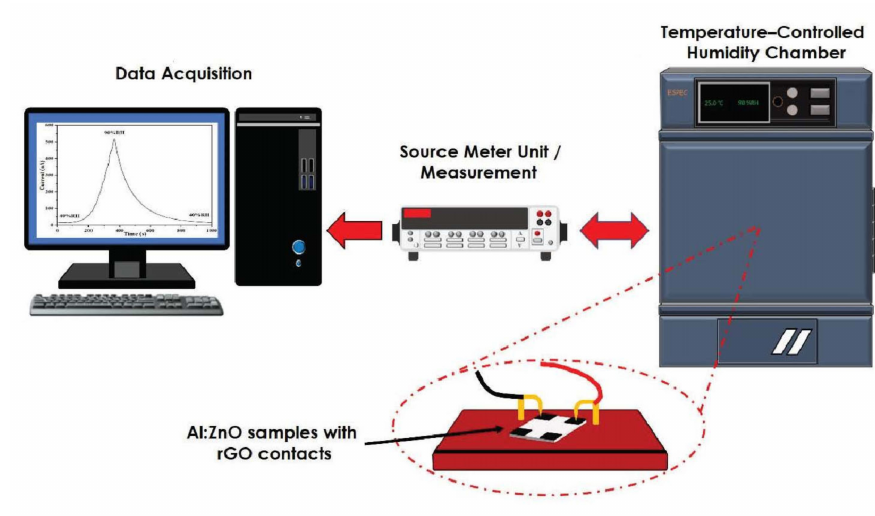
Figure 2. Schematic diagram of the humidity-sensing measurement system